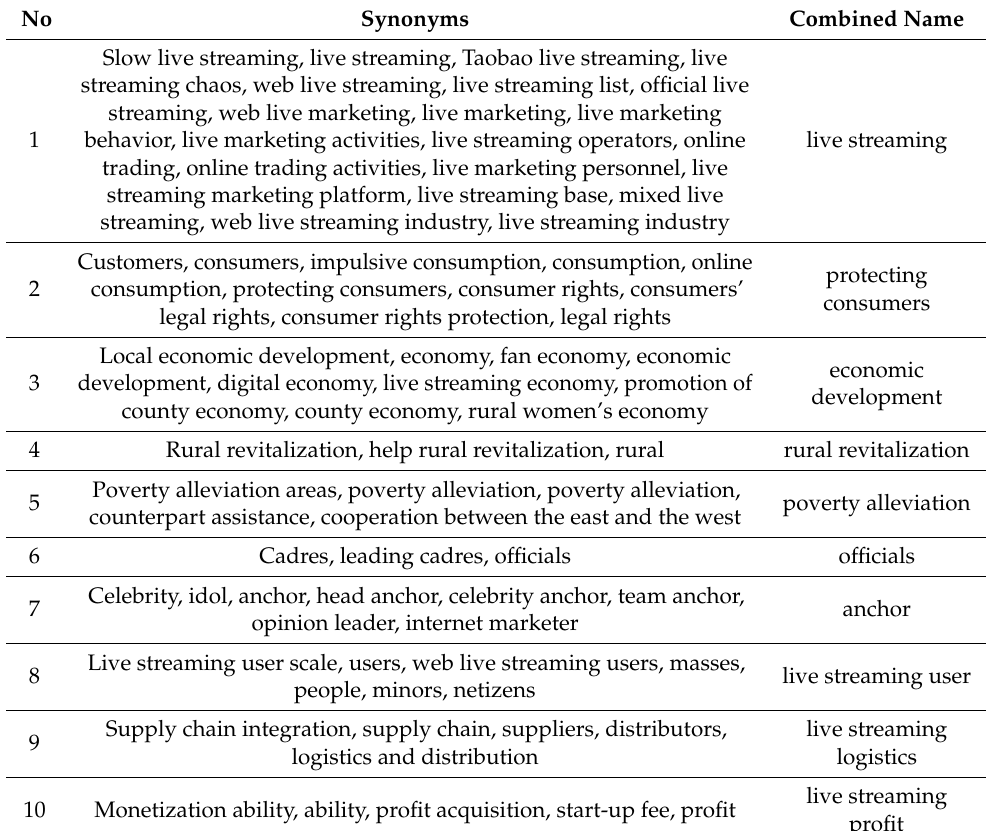
Table 2. Summarize similar keywords (some